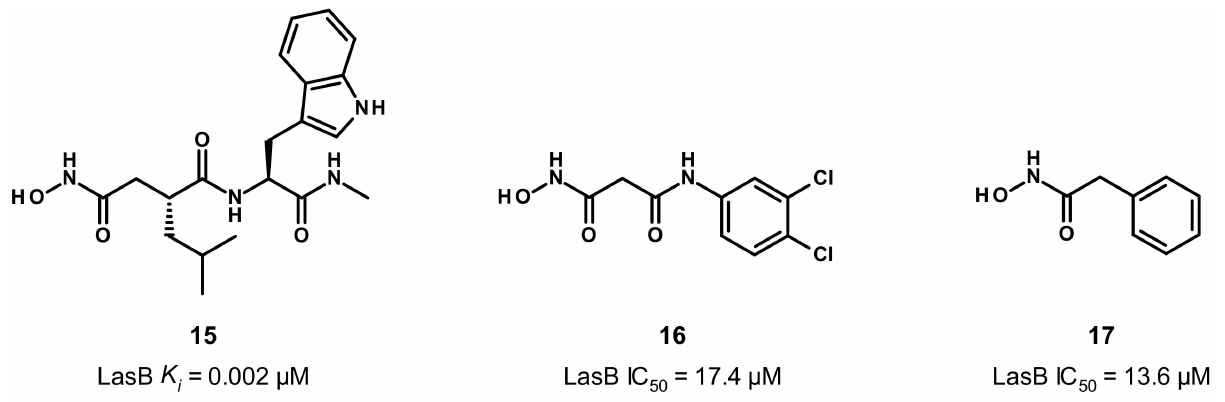
Figure 9. Chemical structures and inhibitory activities of the hydroxamates 15 – 17 . K i and IC 50 values were extracted from the original publications [43,45,46].